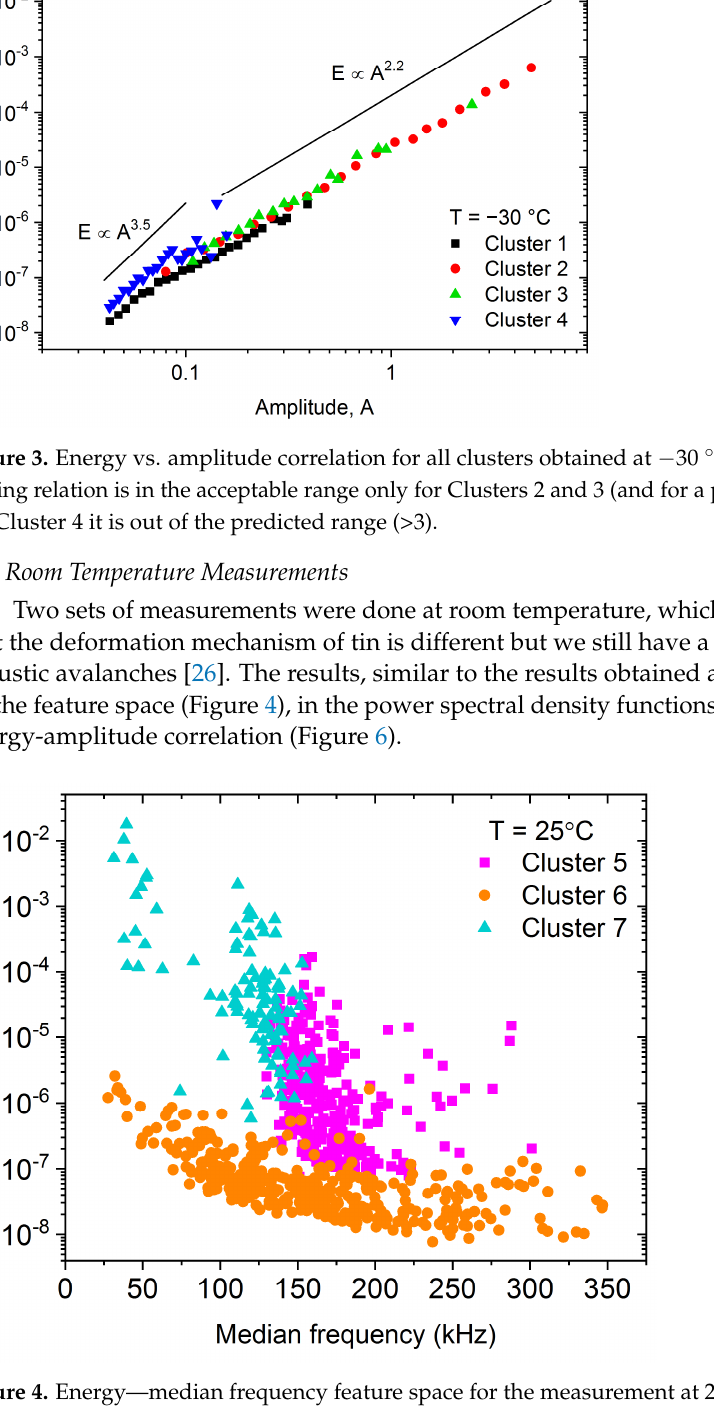
Figure 2. The average PSD functions, as the centroids of the clusters, including the number of ava- lanches at − 30 °C.